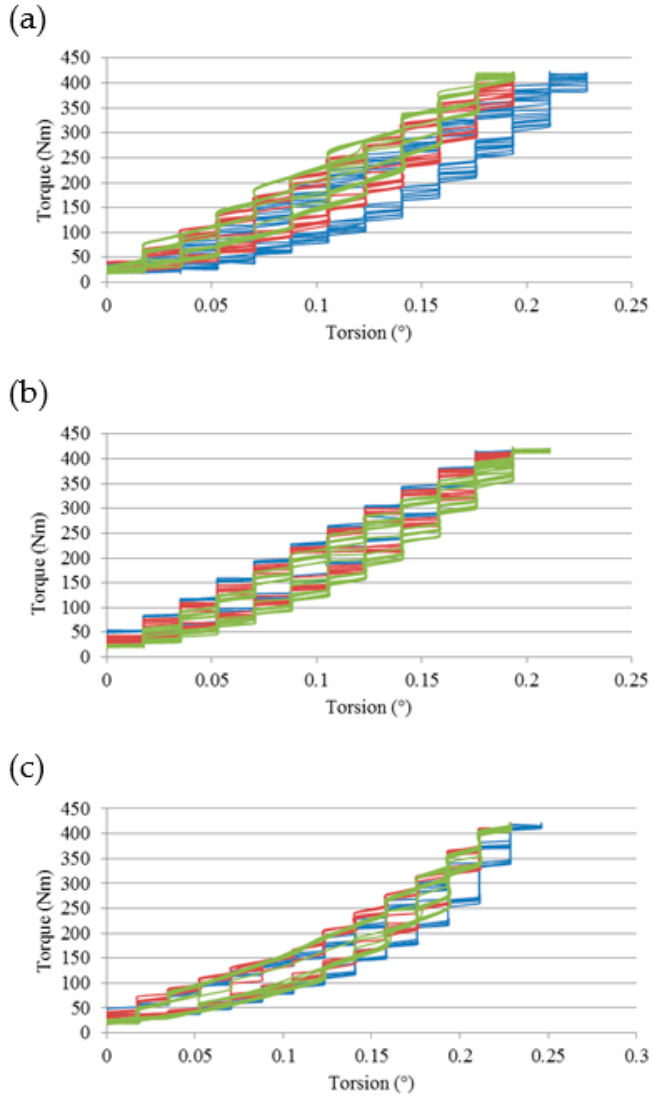
Figure 12. Hysteresis testing from top; ( a ) MR2215 with 6 nm engagement torque, ( b ) MR8728 with 6 nm engagement torque and ( c ) GBC with a 15 nm engagement torque. Loading cycle legend: Green line (5 s), red line (10 s) and blue line (20 s).